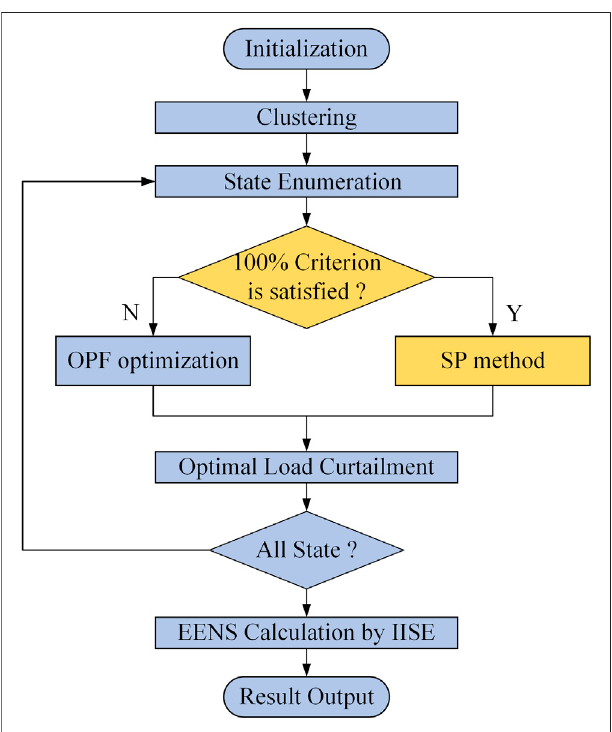
FIGURE 4 | Flowchart of the proposed